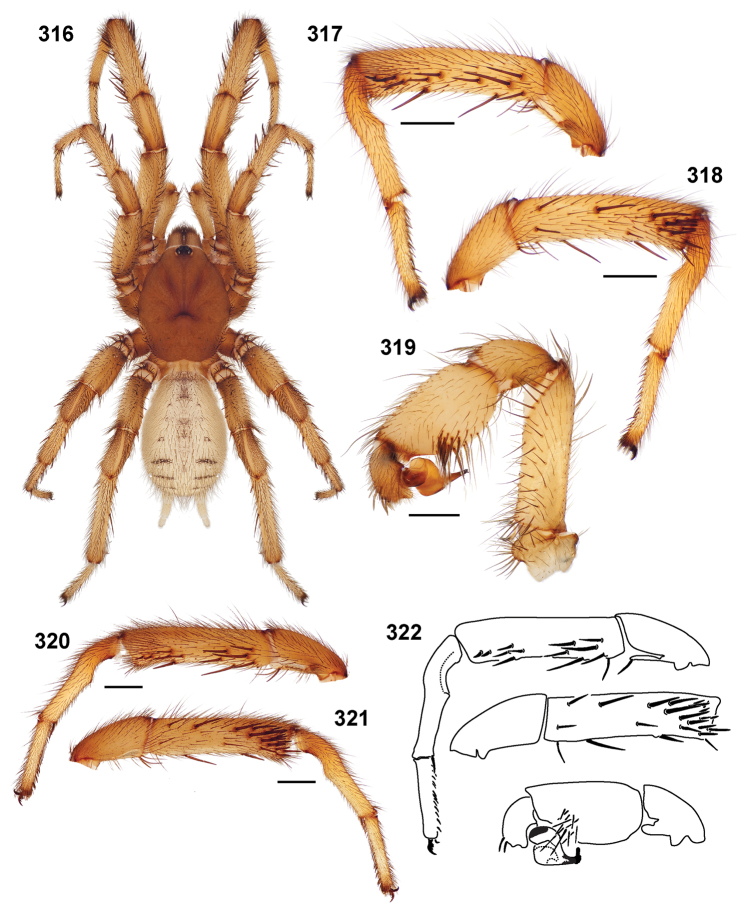
Aptostichus fisheri sp. n. from Kern County; scale bars = 1.0mm. 316 habitus of male paratype (AP954) [806438] 317–319 male holotype (AP955) 317 retrolateral aspect, leg I [806442] 318 prolateral aspect, leg I [806446] 319 retrolateral aspect, pedipalp [806448] 320, 321 male paratype (AP407) 320 retrolateral aspect, leg I [806450] 321 prolateral aspect, leg I [806454] 322 line drawings of leg I spination pattern and pedipalp; retrolateral aspect, patella, tibia, metatarsus, tarsus; prolateral aspect, tibia and patella; retrolateral aspect, pedipalp.